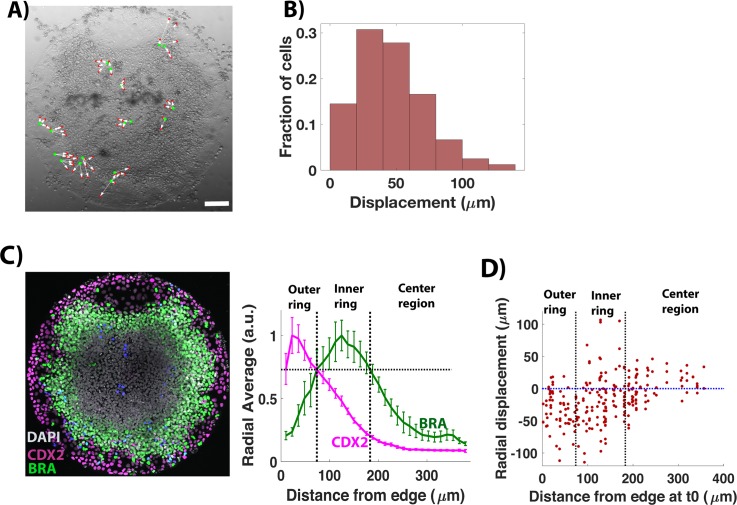
Inward movement of signaling activities is not due to cell movement.(A) Snapshot from time-lapse imaging at 47 h post BMP treatment in the bright field channel. Green and red dots represent initial and final positions, respectively, of labeled cells that were correctly tracked throughout imaging. (B) Histogram of displacement of tracked cells. n = 84 cells. (C) Image of colony (shown in A) immunostained for CDX2, BRA post live cell imaging. Quantification represents average nuclear intensities of indicated markers normalized to DAPI as a function of radial position. Error bars represent standard error of the mean. N = 6. The lines indicate the inner and outer positions of a region of high BRA as a rough guide to the different fate territories (D) Radial displacement of cells as a function of their starting position. Radial displacement = distance of the cell from the center at end of imaging − distance of the cell from the center at the start of imaging. The vertical dotted lines are in the same positions as in (C). The horizontal dashed line separates the cells moving toward the edge from cells moving toward the center. Underlying data can be found in S4 Data. BMP, Bone Morphogenic Protein; BRA, BRACHYURY.